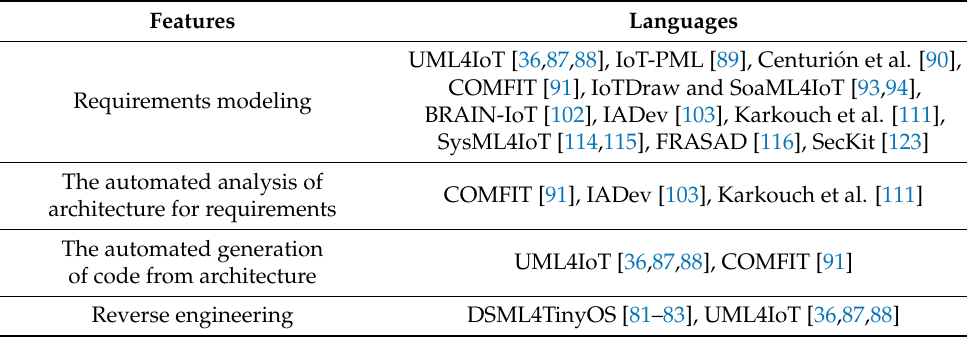
Table 11. The modeling languages for IoT that support software architecture-centric design features. Features